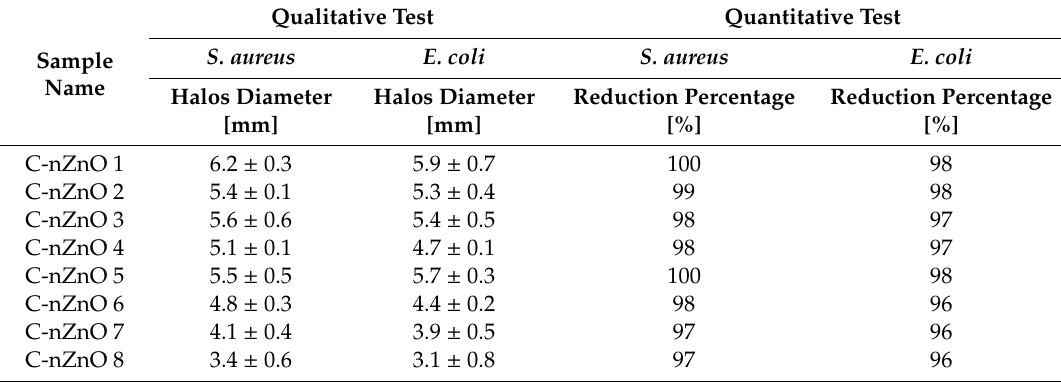
Table 3. Qualitative and quantitative antimicrobial tests for C-nZnO